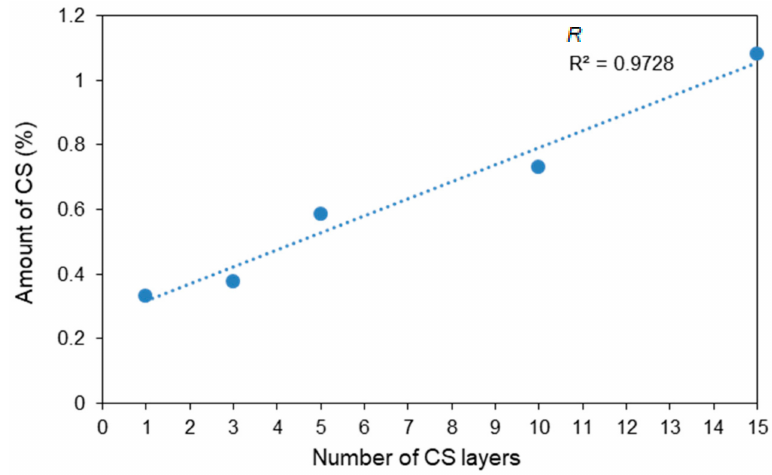
Figure 7. Amount of CS, calculated from the Kjeldahl-determined amount of nitrogen, as a function of the number of CS